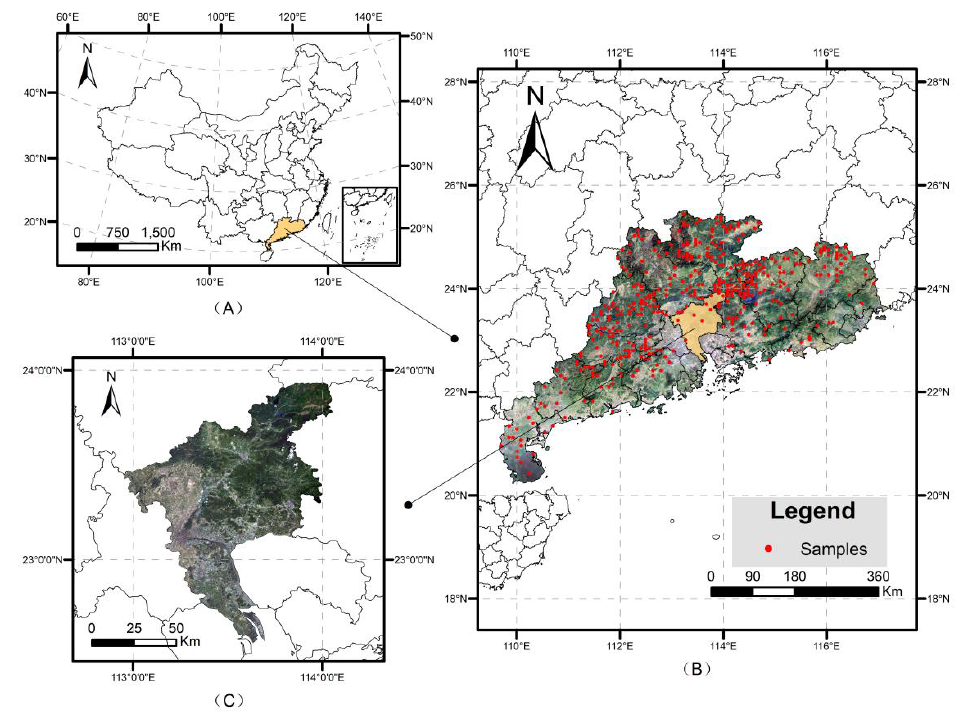
Figure 1. Figure ( A ) shows the scope of China's national boundaries and the location of Guang- dong Province, figure ( B ) shows the distribution of sample points in Guangdong Province and the location of Guangzhou, and figure ( C) shows the scope of